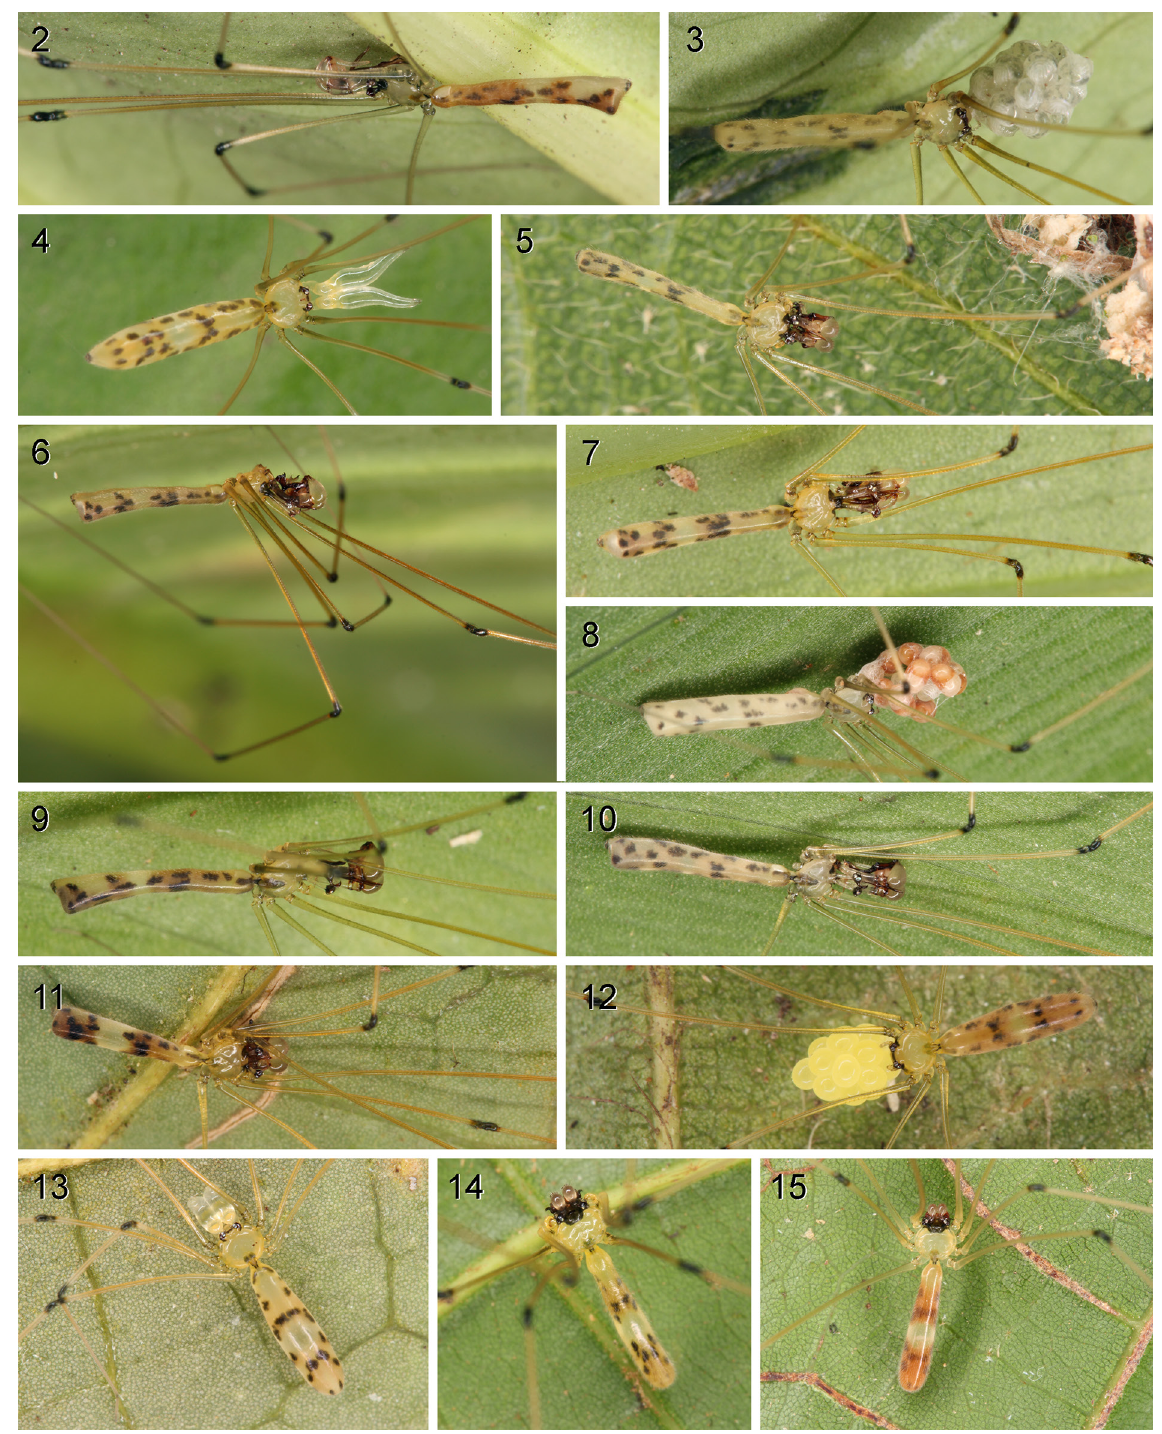
Figs 2–15. Live specimens. 2–4 . Pa. lanthana , Mt. Isarog, ♂, ♀ with eggsac, and penultimate ♂. 5 . Pa. malagos Huber sp. nov., ♂. 6–7 . Pa. casaroro Huber sp. nov., ♂♂. 8–10 . Pa. camiguin Huber sp. nov. 8 . ♀ with parasitized eggsac, from Camiguin Island. 9 . ♂ from Bohol Island. 10 . ♂ from Camiguin Island. 11–13 . Pa. dinagat Huber sp. nov., ♂, ♀ with eggsac, and penultimate ♂. 14–15 . Pa. marilog Huber sp. nov., ♂♂ showing color